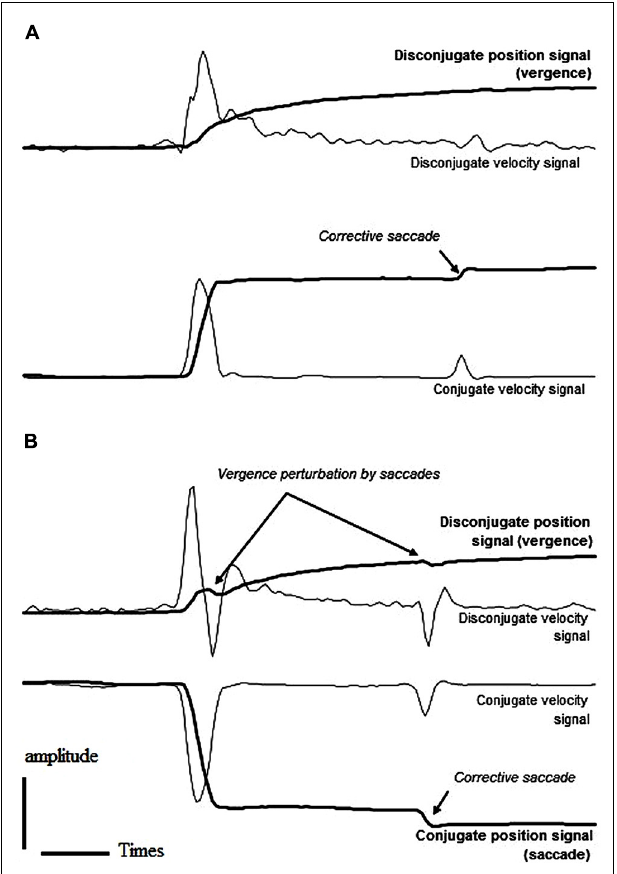
FIGURE 2 | Example saccade and vergence position and velocity signals from a subject performing right (A) and left (B) saccades combined with divergence in the gap task. In both cases, the subject made a corrective saccade.The main and the corrective saccades did not perturb vergence smoothness in the first case (A) while they caused a local change in vergence direction in the second case (B) as indicated by the disconjugate velocity signal (see the text for more